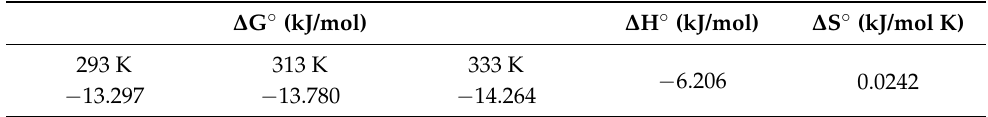
Table 5. Thermodynamic parameters for adsorption of BB-3 on Pd–Ni/AC.